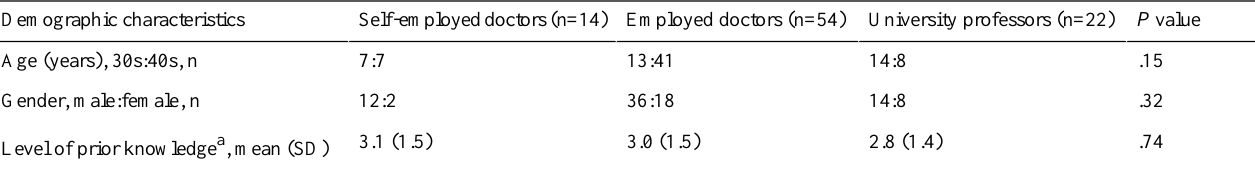
Table 4. Significance of the difference in the demographic characteristics of self-employed and employed doctors and university